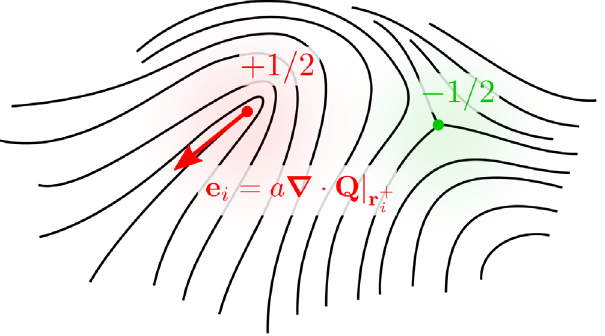
FIG. 1. þ 1 = 2 (red) and − 1 = 2 (green) disclinations in a 2D active nematic with the black lines following the local nematic order. The þ 1 = 2 defect has a local geometric polarity e i shown as a red arrow. Here, a is the defect core size, and the divergence is evaluated at the position r þ i of the defect